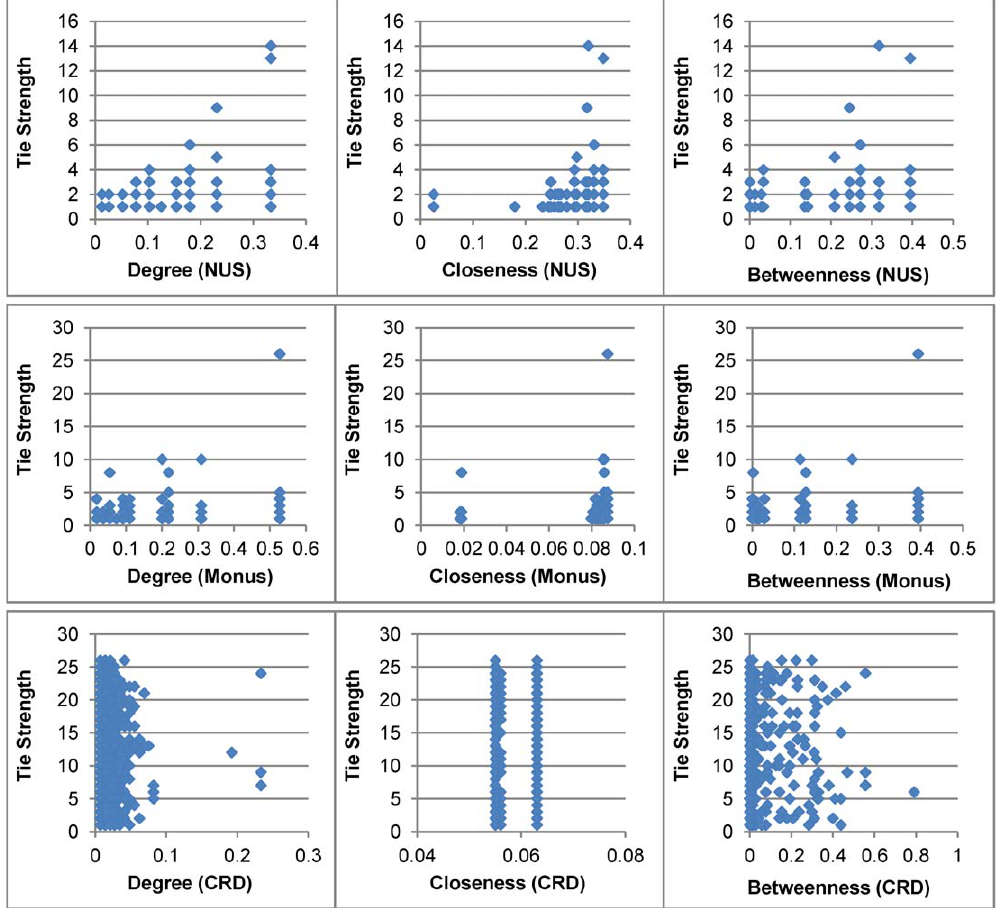
Figure 5. Network attributes for each author and the tiestrength of that author with all her/his co-authors. Three basic centrality measures (i.e., degree centrality , closeness centrality and betweenness centrality ) are considered. CRD stands for ‘ Complete Research Dataset ’.